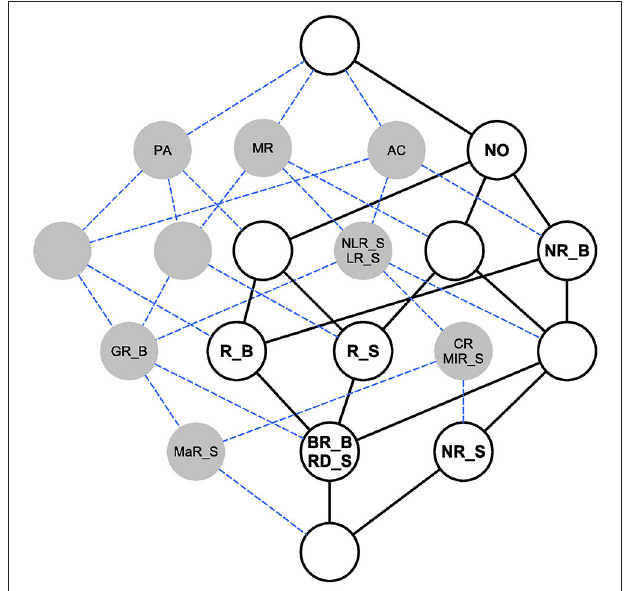
FIGURE 4 | Part of the lattice linked with the attribute “norm” (label NO). Reduced representation, see Figure 2 (figure built with the free software Concept Explorer 1.2; [